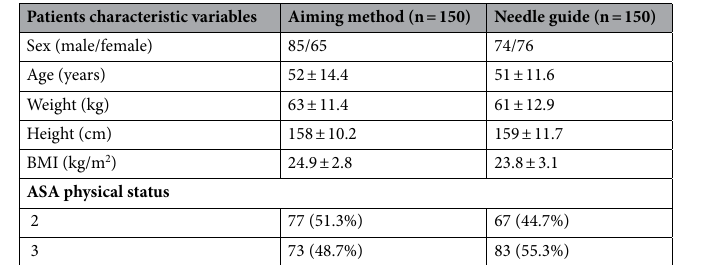
Table 2. Demographic variable of participating